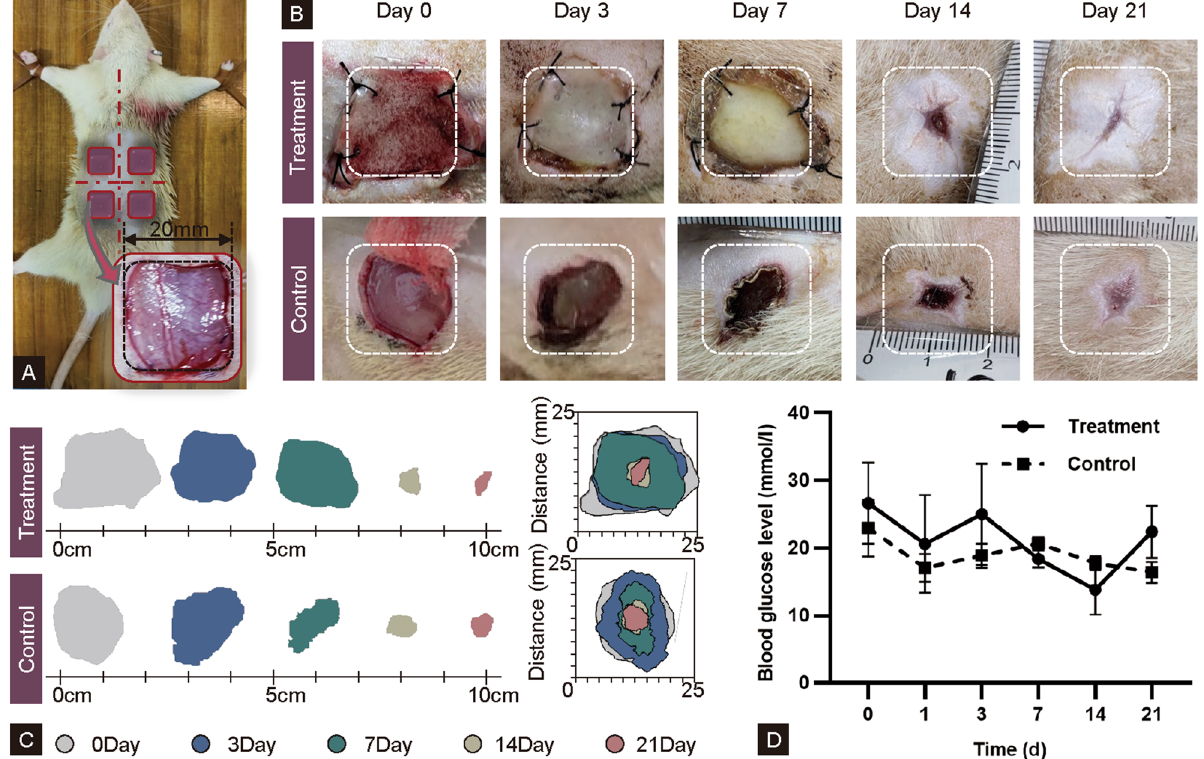
Figure 3. Wound healing in vivo in STZ-induced diabetic rat. ( A ) Schematic illustration of 20 mm diameter and full-thickness wounds created at either side of the dorsal central line. ( B ) Representative photographs of visual appearance of wound excised on rat on days 0, 3, 7, 14 and 21; ( C ) Representative traces of wound-bed closure during 21 days. ( D ) Monitoring of blood glucose level at varied time points. (Treatment = rcBCS group, Control = sham operation